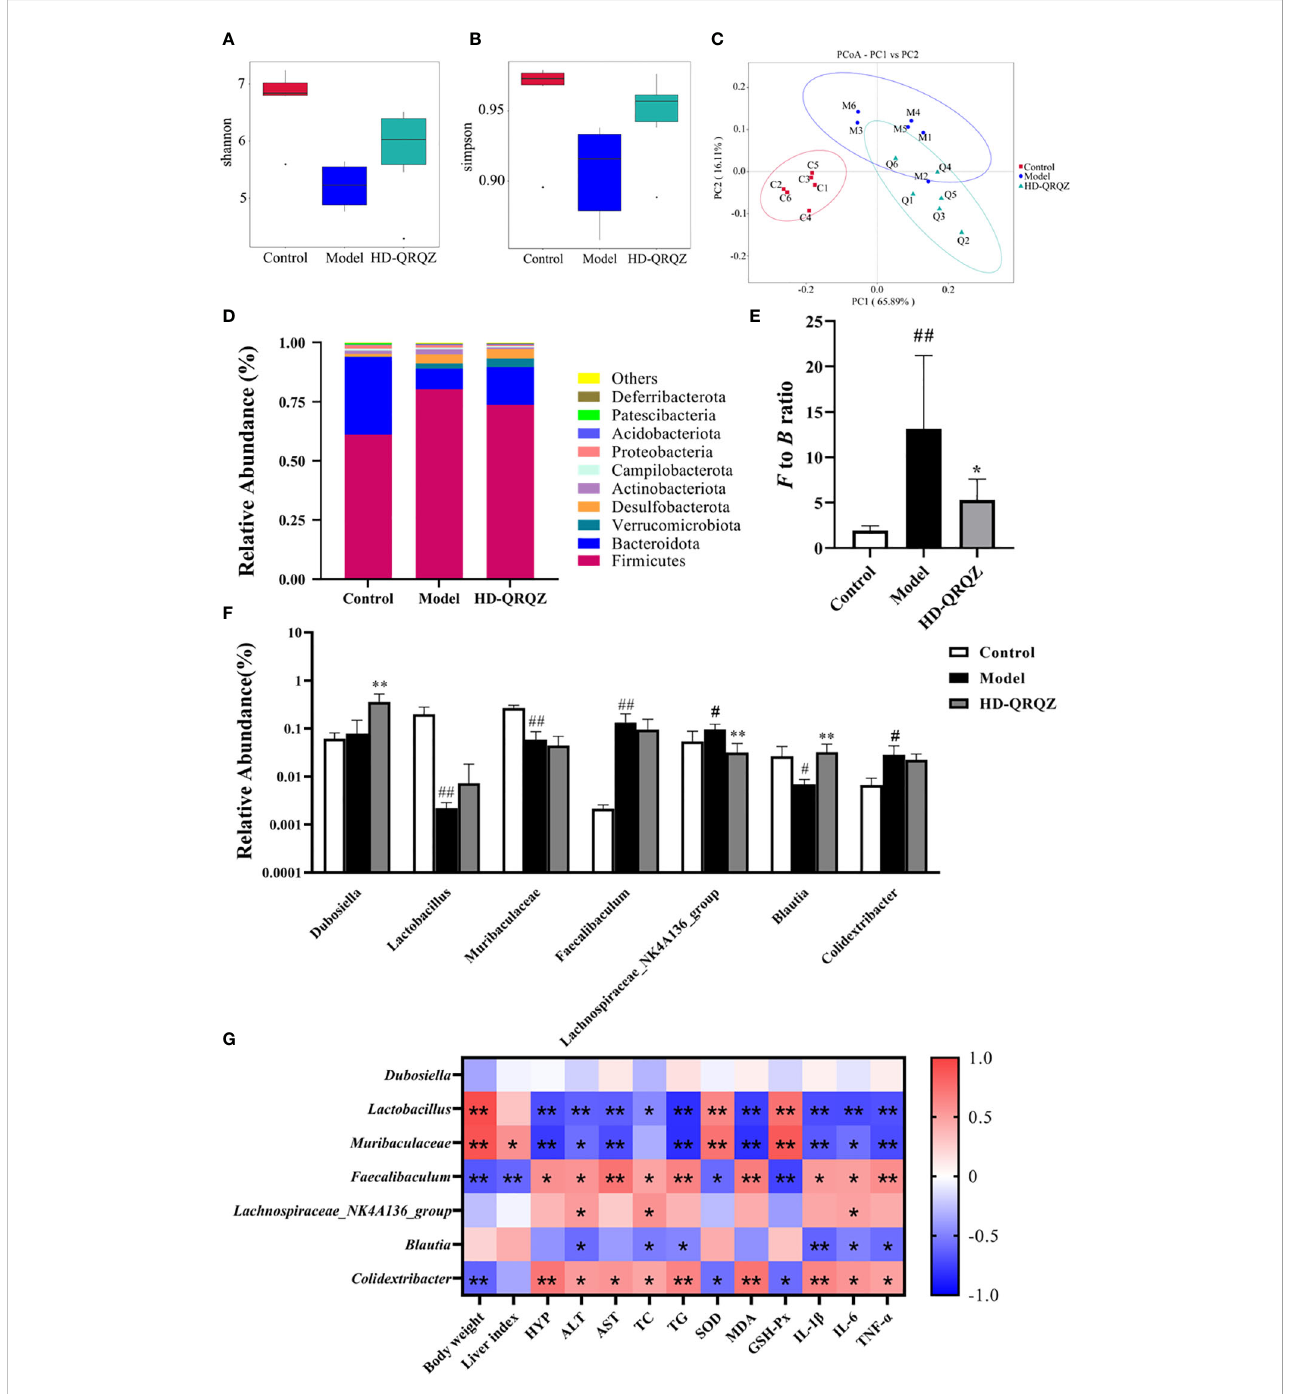
FIGURE 3 QRQZ treatment affected the gut microbiota community in Model mice. (A, B) Shannon and Simpson index was higher in HD-QRQZ group than that in the Model group. (C) PCoA indicated more similar beta diversity between HD-QRQZ and Control groups than that between the Model and Control groups (C: Control group; M: Model group; Q: HD-QRQZ group). (D, E) At the phylum level, QRQZ treatment decreased the F to B ratio in Model mice. (F) At the genus level, QRQZ treatment affected the relative abundances of Dubosiella, Lachnospiraceae_NK4A136_group, Blautia , in Model mice. (G) Correlation analysis of therapeutic indicators and changed gut microbiota using spearman ’ s analysis (heatmap). Color coding scale indicates the pearson correlation coef fi cient from heatmap, the deeper red or blue indicates the higher absolute of the value. * P < 0.05, ** P < 0.01. Control, Model and HD- QRQZ (n = 6 per group) groups. Data are presented as the mean ± standard deviation. # p < 0.05 as compared to the control group; ## P < 0.01 as compared to the Control group; * P < 0.05 as compared to the Model group; ** P <